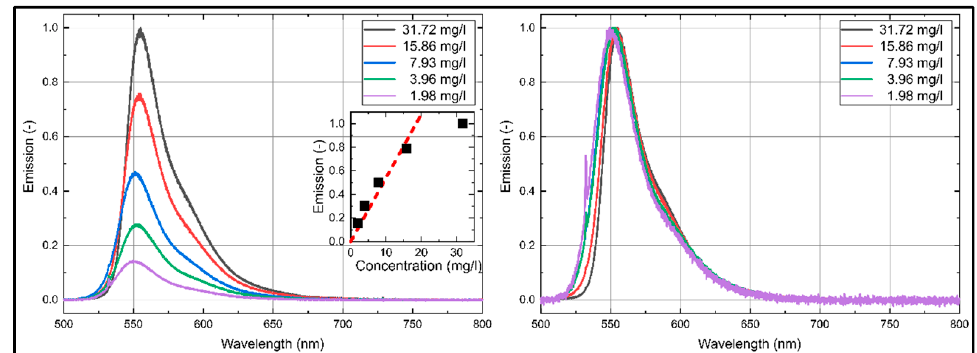
Figure 4. Emission spectra ( left : normalized to maximum intensity of 31.72 mg/L; right : normalized to the respective maximum intensity) of Eosin-Y dissolved in ethanol, inserted diagram show linearity ( R 2 = 0.980) of the integral LIF-signal for various dye concentrations; 293 K, 0.1 MPa.